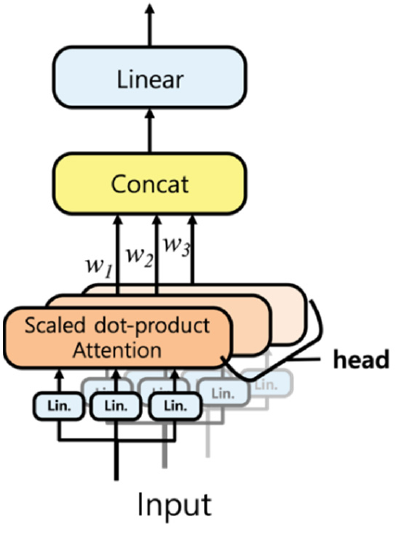
Figure 2. Weighted multi-head self-attention.